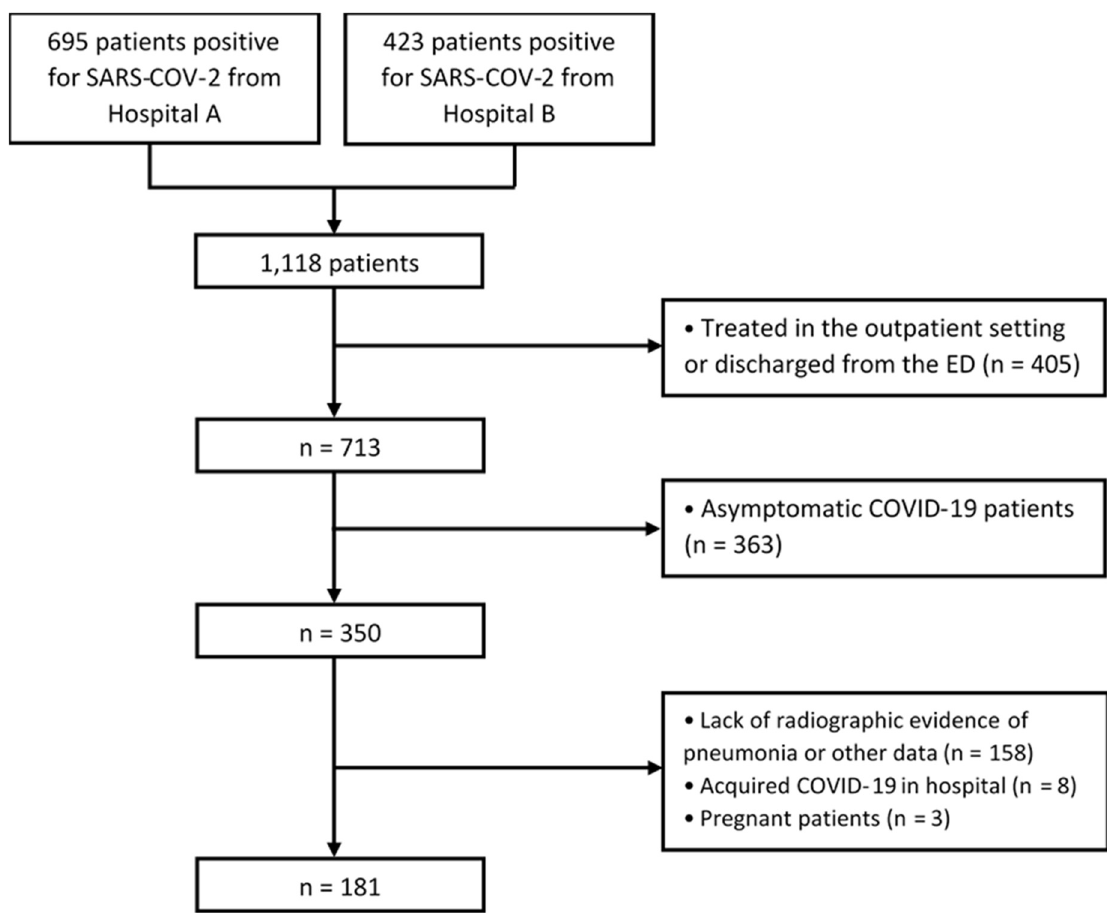
Fig 1. Flowchart of inclusion and exclusion